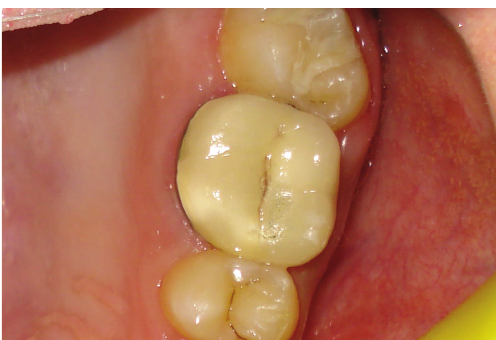
Figure 7: The metal-ceramic crown was cemented with self- adhesive resin